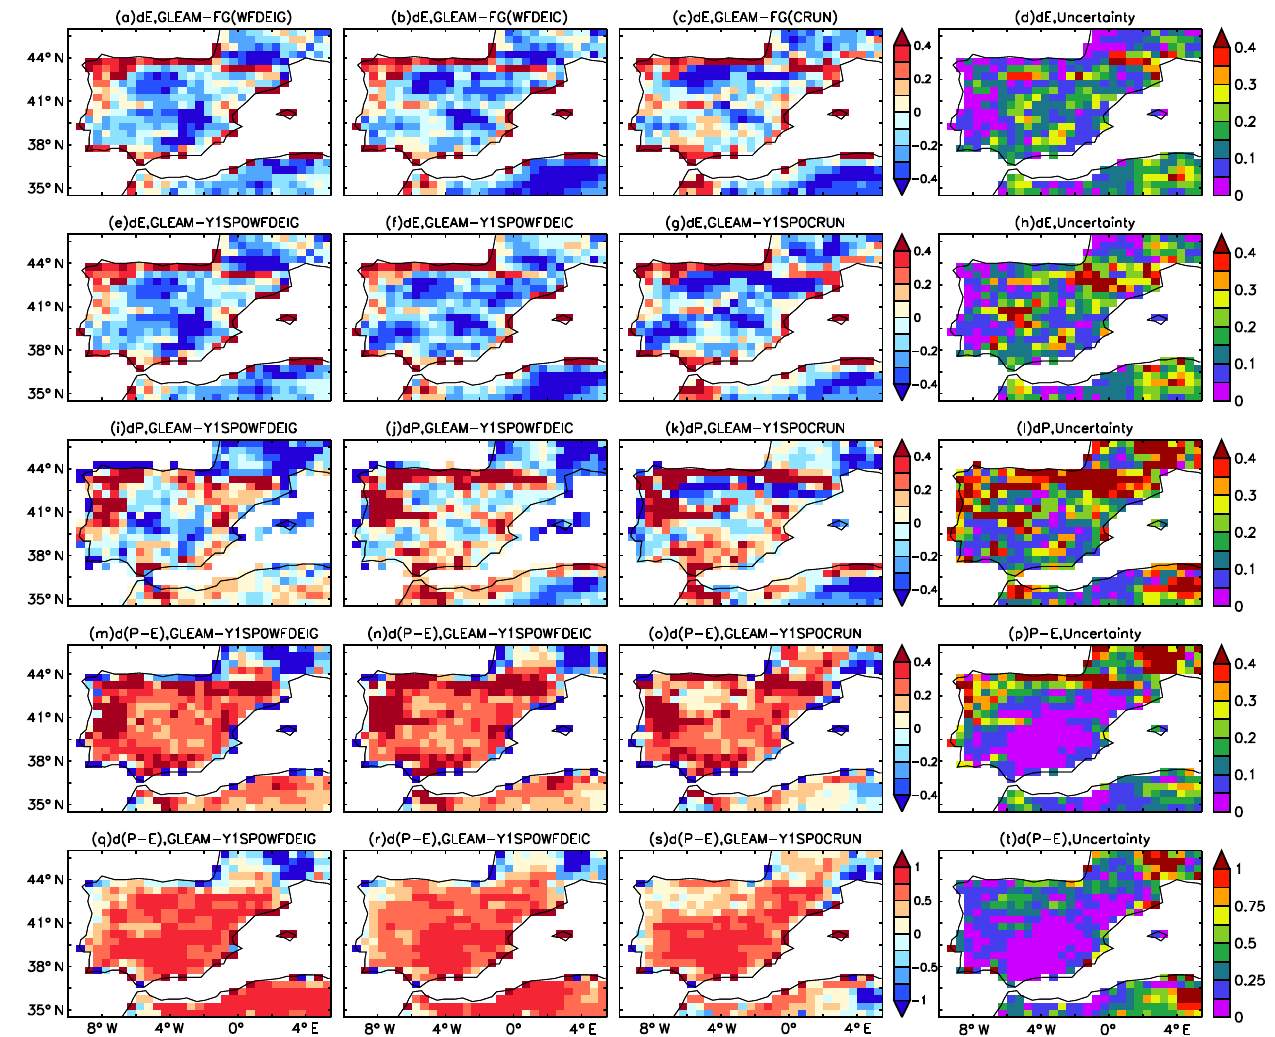
Figure 12. Comparison of evaporation ( E , in mmday − 1 , 1st row) between GLEAM (v3.1) and FG (First Guess), as well as E (2nd row), precipitation ( P , in mmday − 1 , 3rd line), P − E (in mmday − 1 , 4th row) and P − E (relative value between 0 to 1, 5th line) between GLEAM (v3.1) and assimilated values using different forcings (1st column: WFDEI-GPCC; 2nd column: WFDEI-CRU; 3rd column: CRU-NCEP; 4th column: “Uncertainty” (defined by Eq. 10) of using different forcing) averaged from 1980 to